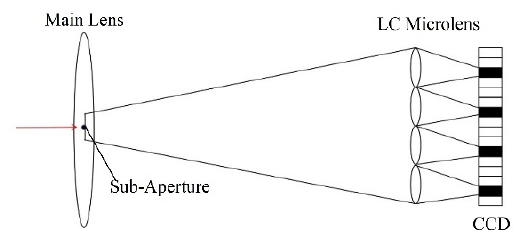
Figure 3. View angle image extraction schematic diagram.